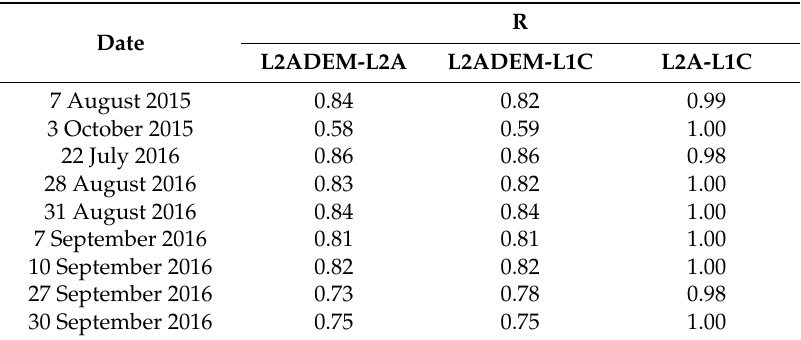
Table 6. Correlation between the treefall gap abundance rasters on different data types on different dates on